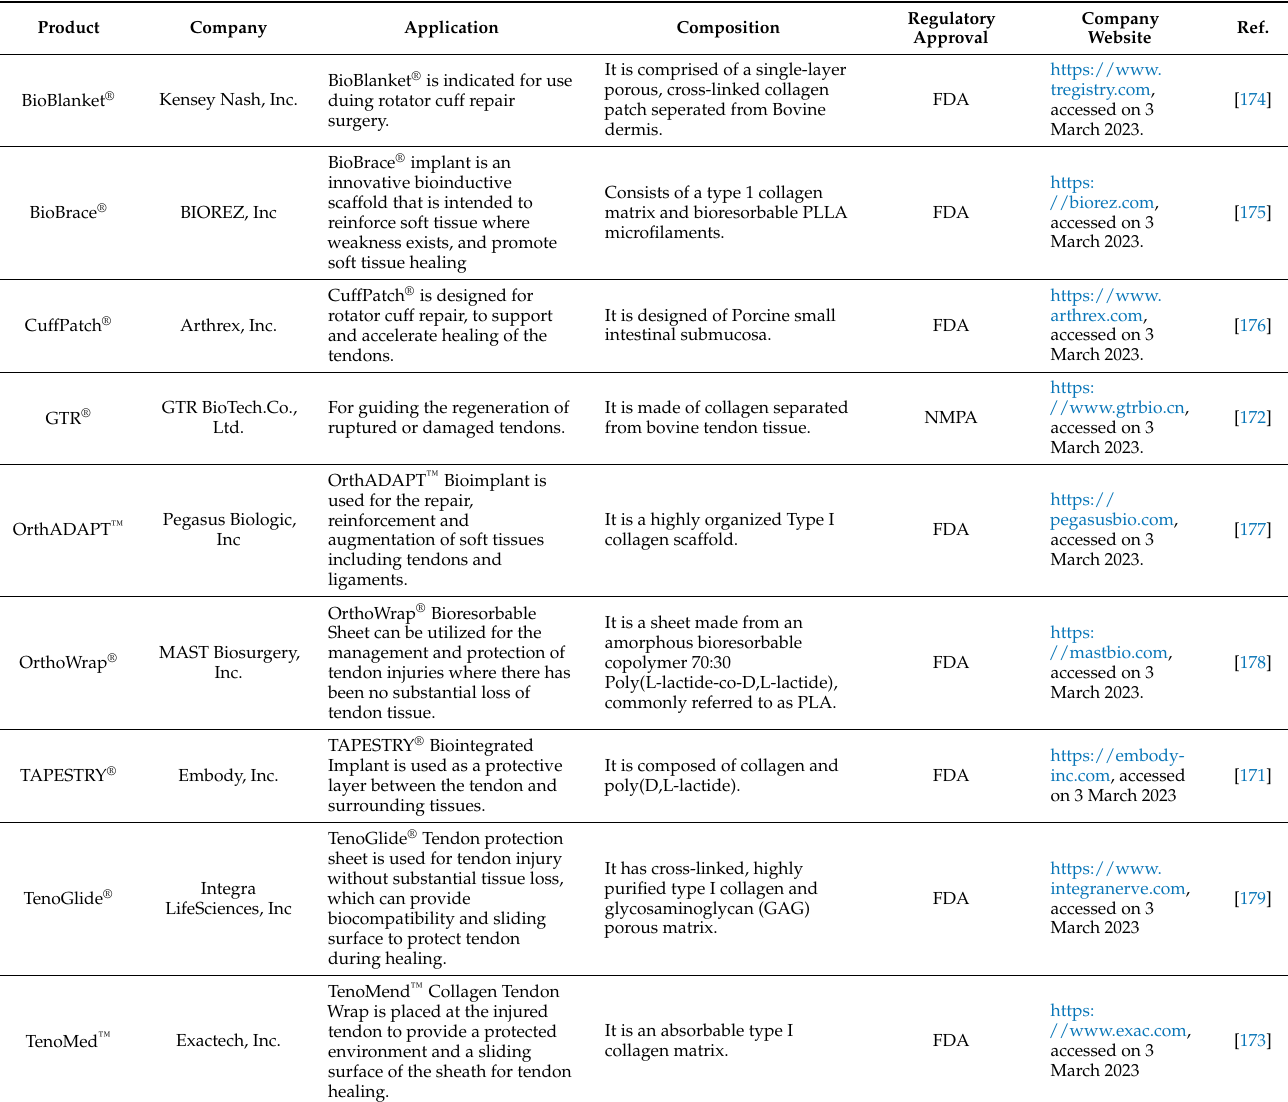
Table 3. FDA-registered commercial products for tendon